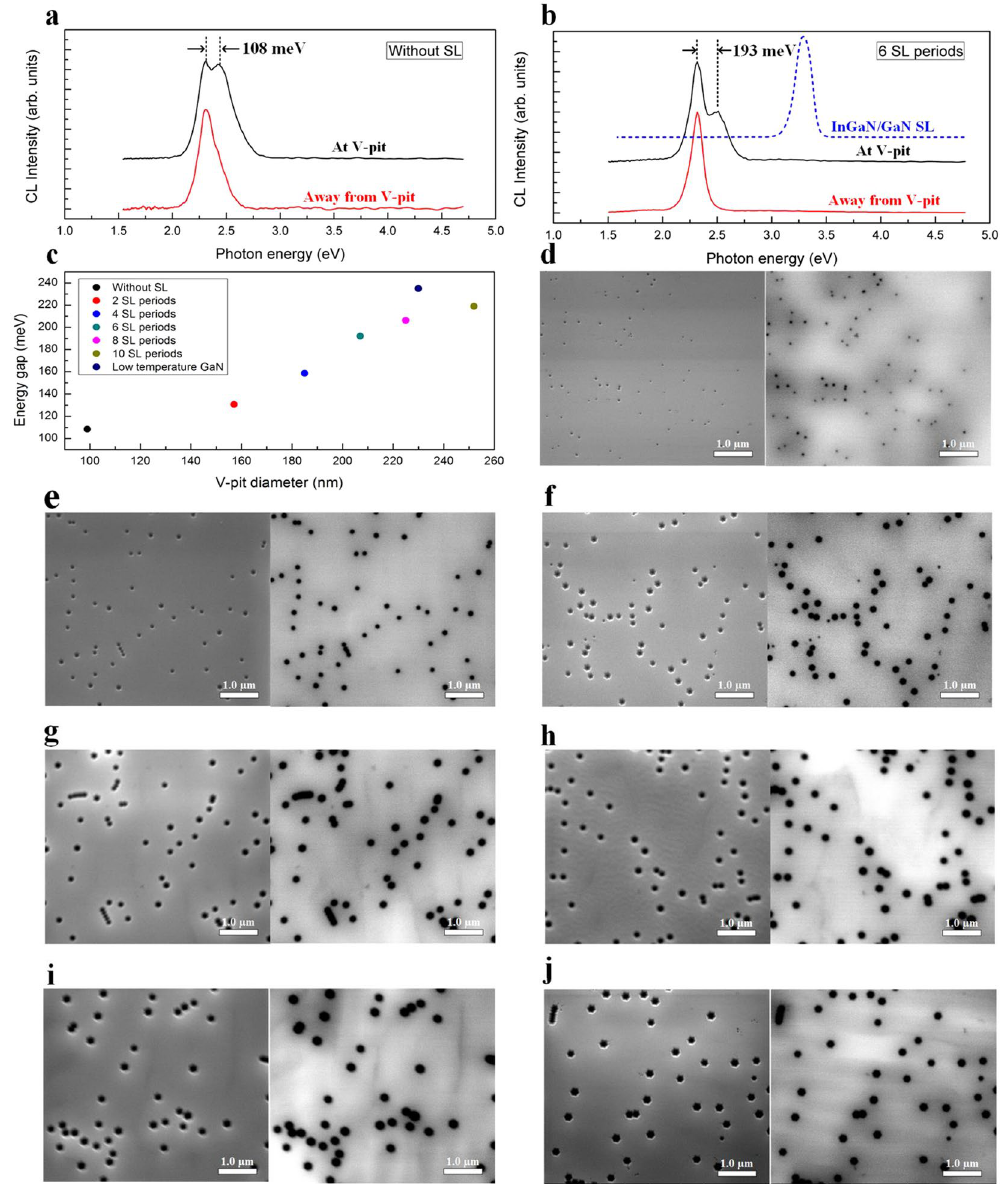
Figure 5. CL spectra measured from the green MQWs grown ( a ) without an SL and ( b ) on 6 SL periods and the sample with only SL grown on n-GaN layer. ( c ) V-pit diameter dependence of the energy gap between the main energy peak and the high-energy shoulder peak in CL spectra around the V-pits at 300 K. Top-view SEM and panchromatic CL images of the green MQWs grown ( d ) without an SL and on ( e ) 2 SL periods, ( f ) 4 SL periods, ( g ) 6 SL periods, ( h ) 8 SL periods, ( i ) 10 SL periods, and ( j ) a low-temperature GaN